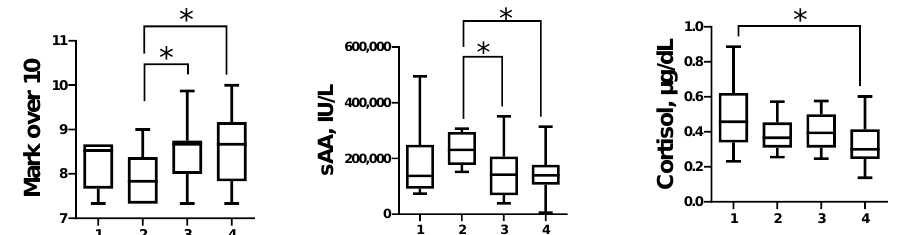
Figure 4. Boxplots representing median, interquartile, and range data of Likert (Likert_Pre) and STAI (STAI_Pre) data before activity; and the difference after-before of Likert (Likert_Pre-Post) and STAI (STAI_Pre-Post) data reported by students. Group 1 included students that showed a decrease in both sAA and cortisol after the activity ( ↓ sAA & ↓ cortisol); Group 2 included students that showed a decrease in sAA but an increase in cortisol ( ↓ sAA & ↑ cortisol); Group 3 included students that showed an increase in sAA and a decrease in cortisol concentrations ( ↑ sAA & ↓ cortisol), and Group 4 included students that showed an increase in concentration of both sAA and cortisol after the activity ( ↑ sAA & ↑ cortisol). 4. Discussion In this manuscript, the measurements of cortisol and alpha amylase in saliva were used to assess the stress that an academic situation can produce in journalism students. These biomarkers have been used previously to evaluate stress in university students. For example, salivary cortisol and sAA have been measured in psychology students who